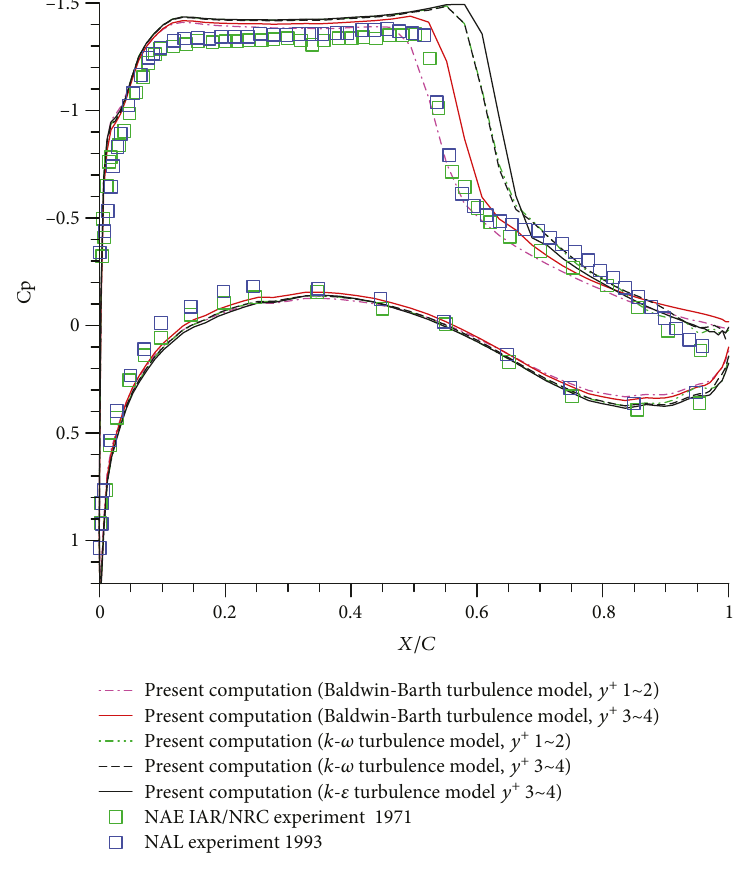
Figure 7: Pressure distribution at M = 0 738 and angle of attack α = 3 52 ° . Table 1: Lift and drag coe ffi cient